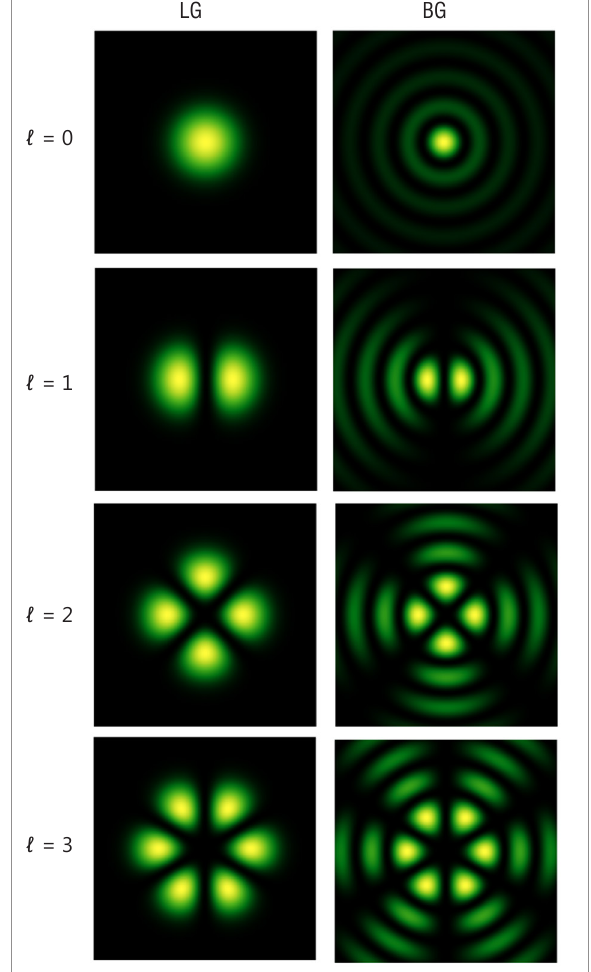
Figure 1: Intensity distributions for superposition modes of orbital angular momentum for different azimuthal indices. For each image, the superposition is between azimuthal phase indices of equal magnitude but opposite sign, ℓ and – ℓ . Both bases, Laguerre–Gaussian (LG) and Bessel–Gauss (BG), can be used to measure orbital angular momentum. The radial component for the LG basis has been set to zero in each case, while an arbitrary radial component was chosen for the BG basis and kept constant for each